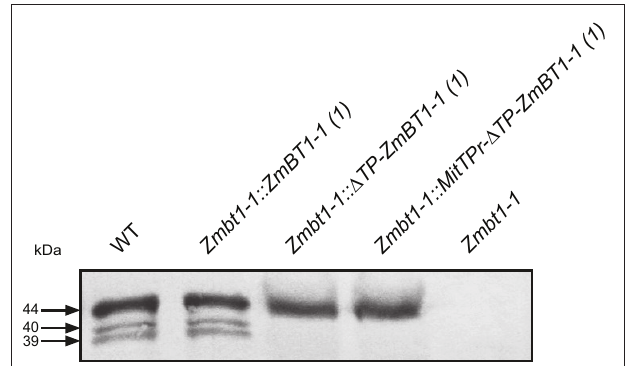
FIGURE 1 | Western blot analysis of ZmBT1-1 in proteins extracted from 24 DAP WT (W23/M14/W64A), Zmbt1-1::ZmBT1-1, Zmbt1-1:: 1 TP-ZmBT1-1, Zmbt1-1::MitTPr- 1 TP-ZmBT1-1, and Zmbt1-1 endosperms. The gel was loaded with 30 µ g protein per lane.